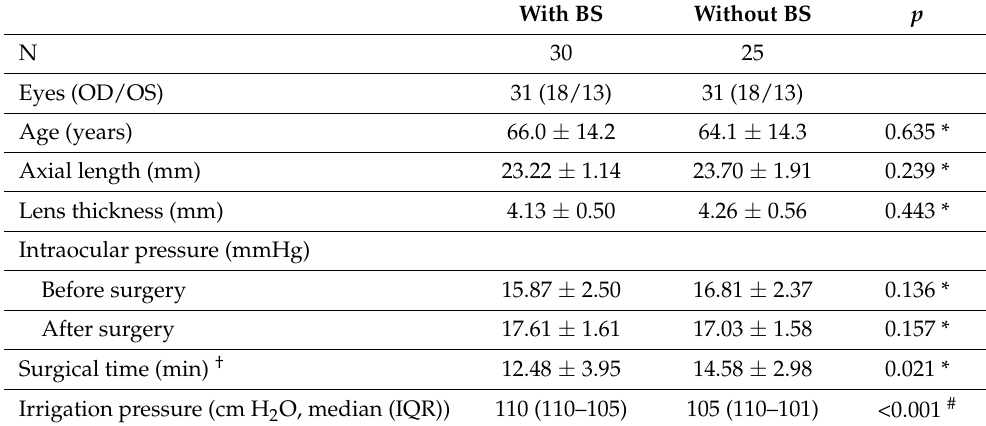
Table 1. Clinical characteristics of patients with and without postoperative Berger’s space (BS).